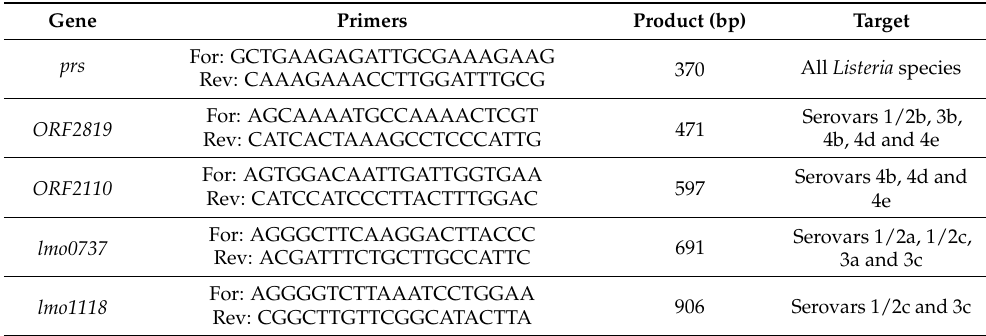
Table 2. Primer list, desired concentration and predicted sizes of PCR products for the molecular identification and molecular serotyping of Listeria monocytogenes